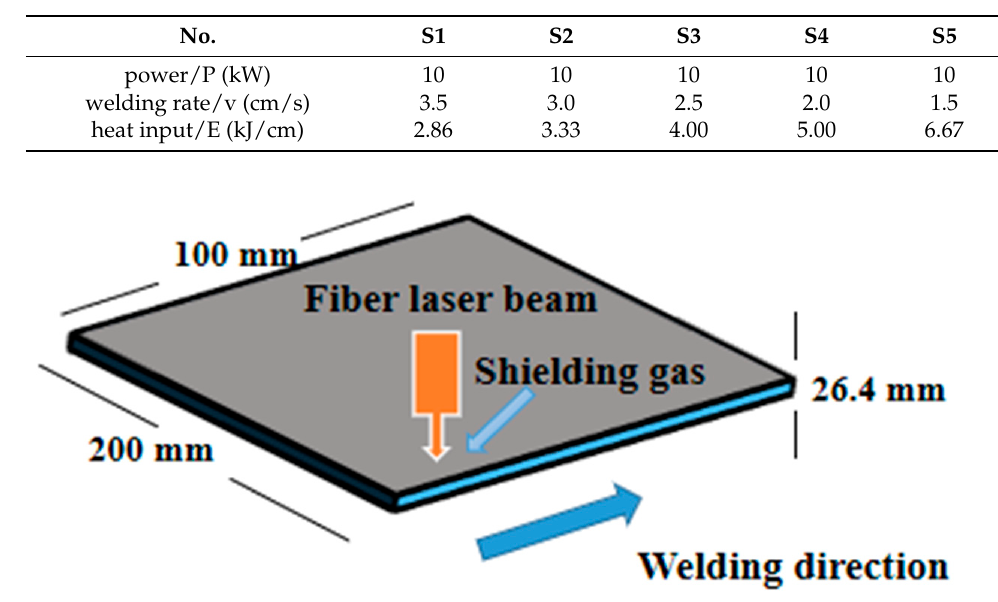
Table 1. The specific experimental parameters in the laser welding procedures.